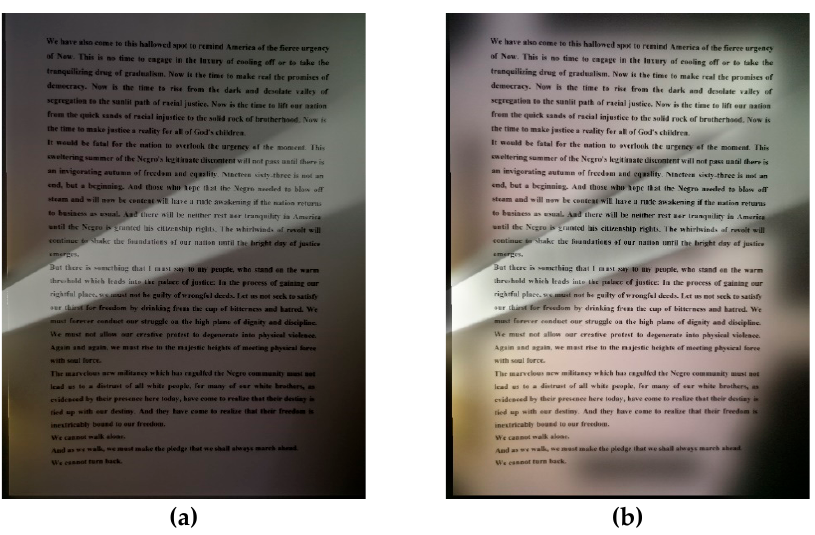
Figure 11. HDR fusion method: ( a ) Mertens’ method ( b ) Goshtashy’s method.